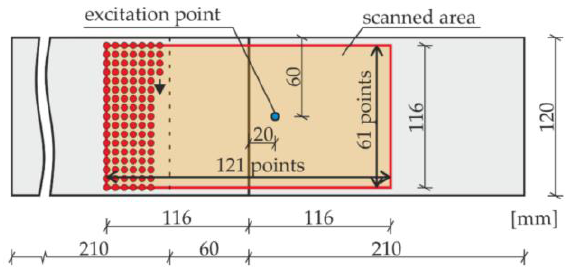
Figure 5. Investigated specimen with indicated scanning